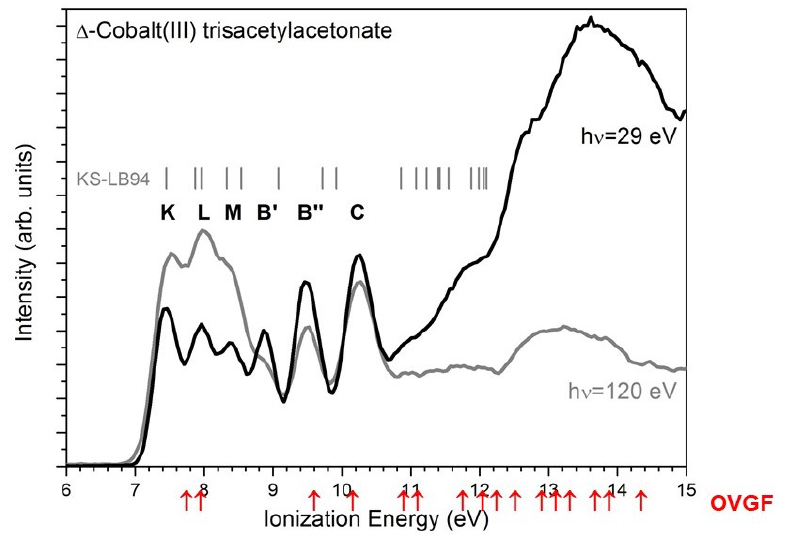
Figure 5. Valence photoelectron spectrum of cobalt tris-acetylacetonate, with LB94 eigenvalues (black) and OVGF IEs (red). Experimental spectrum from [51] with